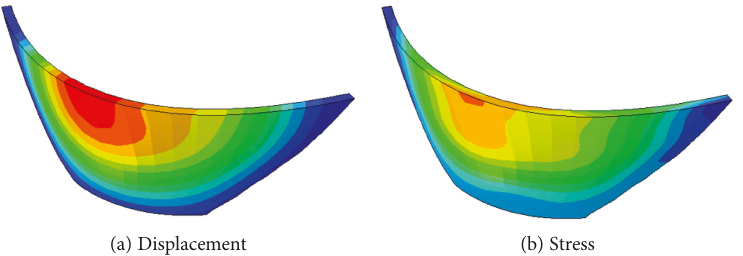
Figure 6: Displacement and stress distribution of arch dam under self-weight and hydrostatic pressure.